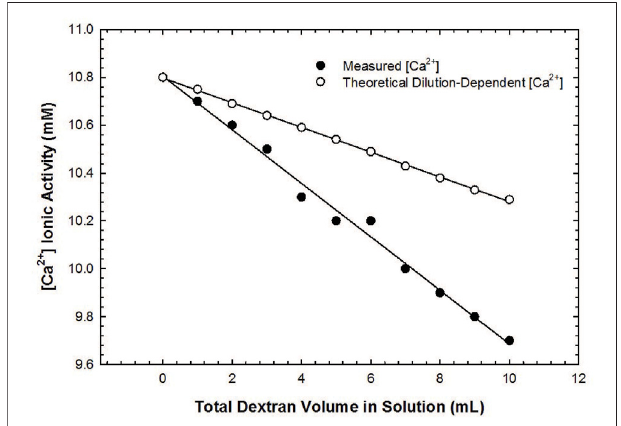
FIGURE 5 | Change in calcium ion concentration as a function of dextran